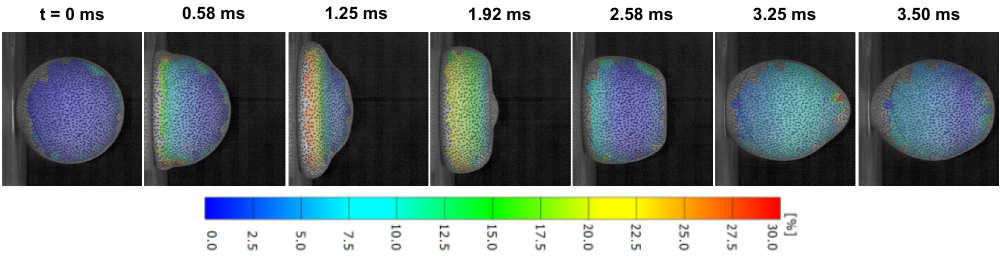
Figure 5. Surface coverage and major stain (%) during impact (30.5 m ∙ s − 1 , 90°). t = time in milliseconds.